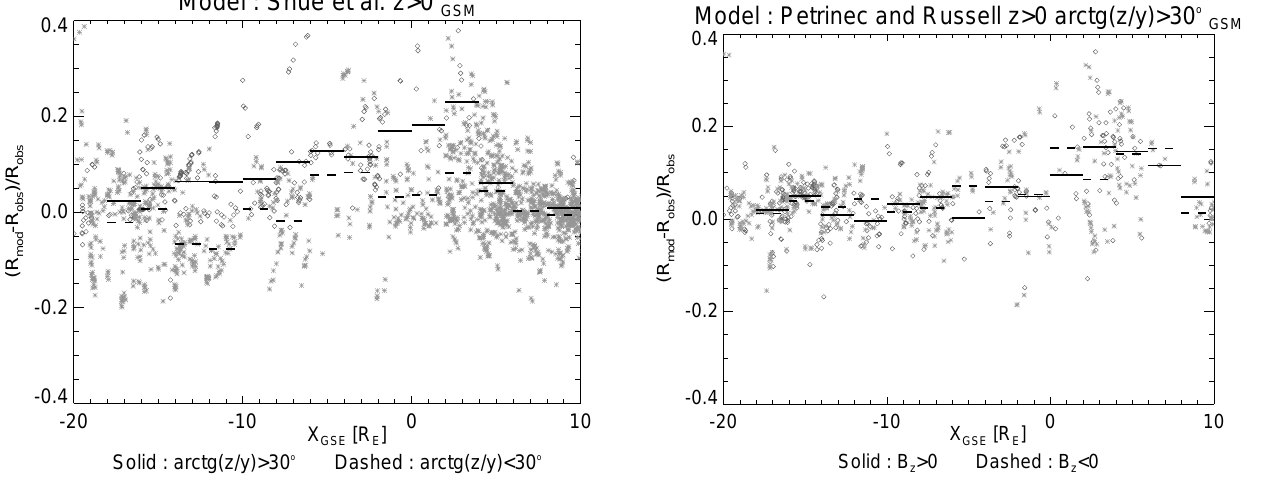
Fig. 3. The same as Fig. 2 for the S97 model.